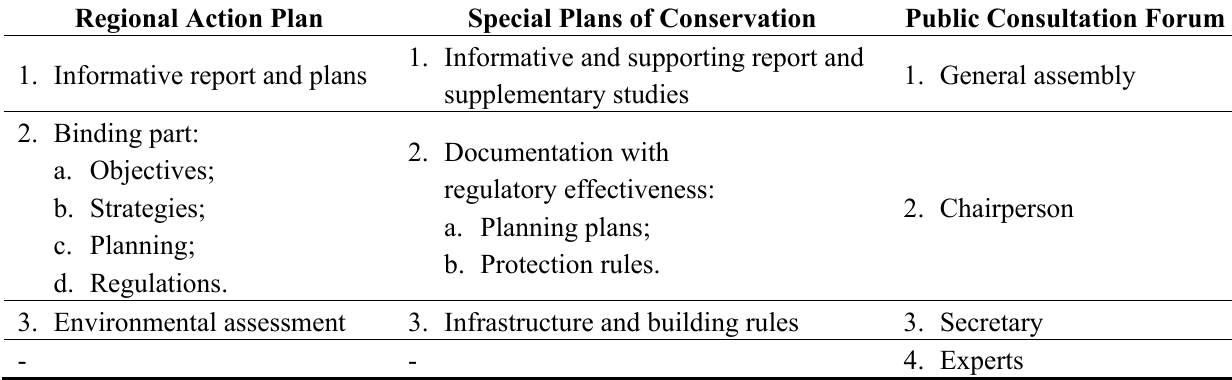
Table 4. Proposed planning